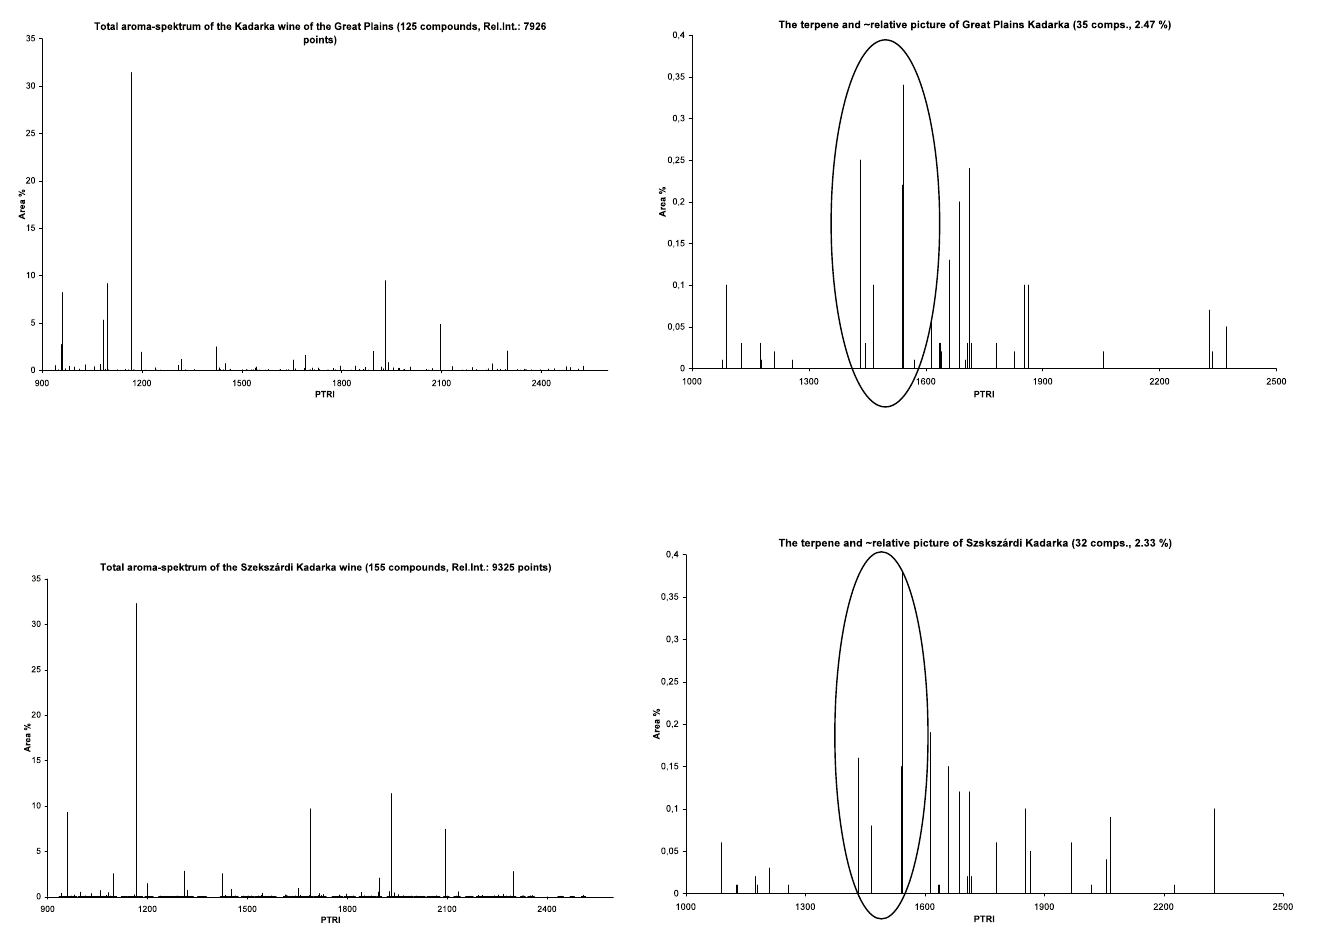
Fig. 2: The total (left side) and the primary aroma-structure (right side) of the two Kadarka wines